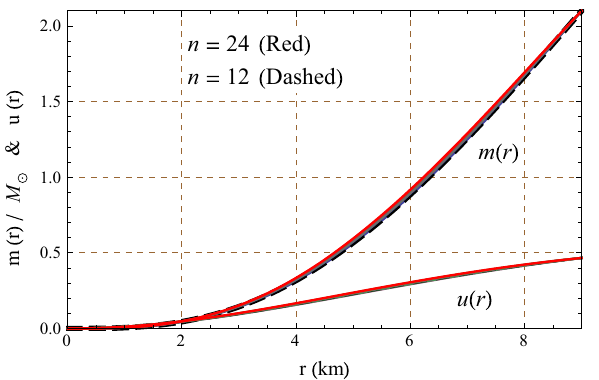
Fig. 5 Variationofmassfunctionwithradialcoordinate fortheparam-